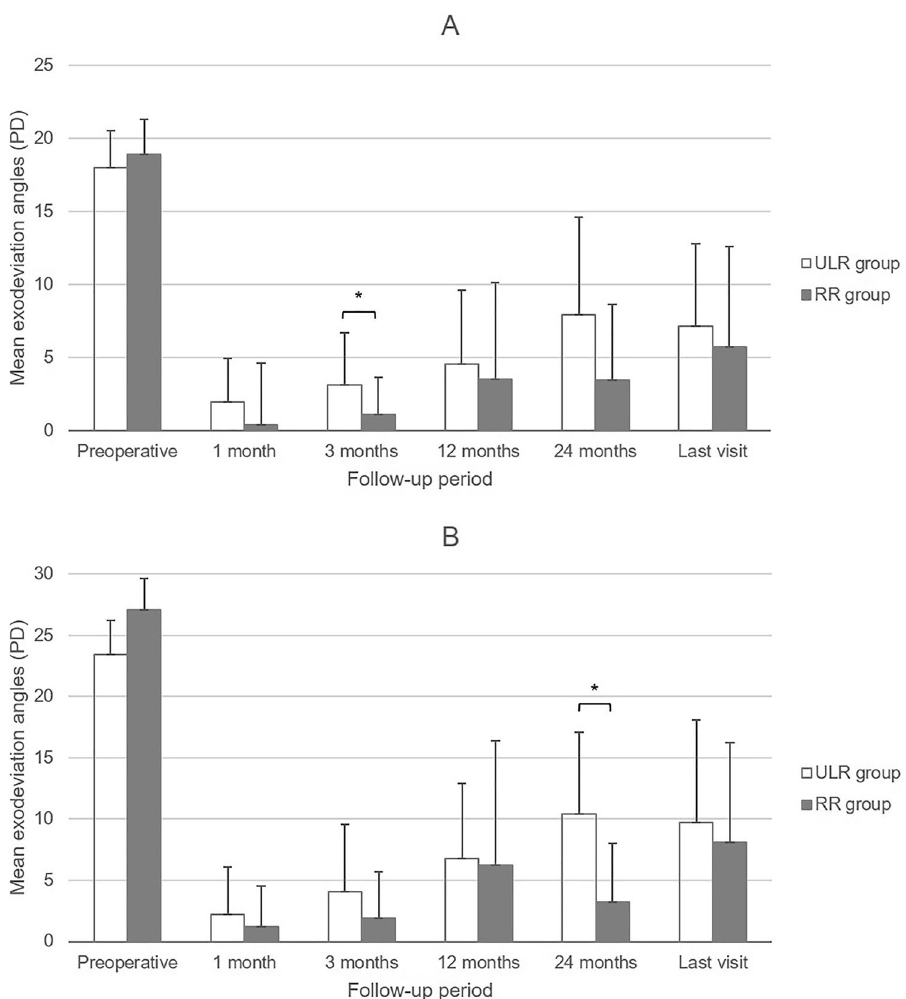
Figure 1. The mean pre- and postoperative exodeviation angles (PD) ( A ) at distance, and ( B ) at near in ULR group (n = 30) and RR group (n = 27). ULR group = patients who underwent unilateral lateral rectus recession. RR group = patients who underwent unilateral lateral rectus recession-medical rectus resection. PD = prism diopters. *Statistically significant between the 2 groups in Mann–Whitney U test ( P < 0.05).